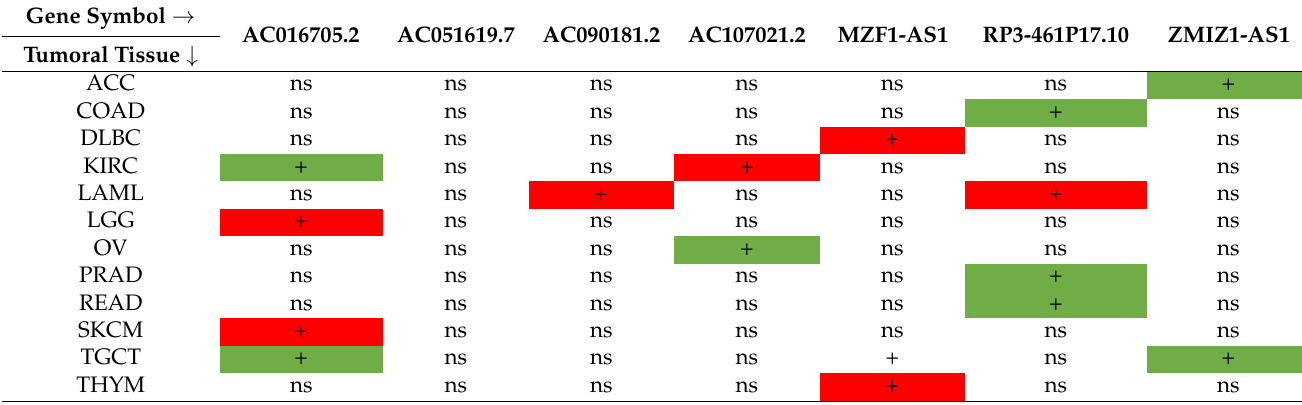
Table 6. Correlation of lncRNAs with expression in cancer. Deregulation is investigated in tumoral versus healthy tissue using GEPIA2 database and reported as ns (non-significant deregulation), a green + (upregulation in normal tissue) and a red + (upregulation in tumoral tissue). ACC: Adrenocortical carcinoma; COAD: Colon adenocarcinoma; DLBC: Lymphoid neoplasm diffuse large B-cell lymphoma; KIRC: Kidney renal clear cell carcinoma; LAML: Acute myeloid leukemia; LGG: Brain lower grade glioma; OV: Ovarian serous cystadenocarcinoma; PRAD: Prostate adenocarcinoma; READ: Rectum adenocarcinoma; SKCM: Skin cutaneous melanoma; TGCT: Testicular germ cell tumors; THYM: